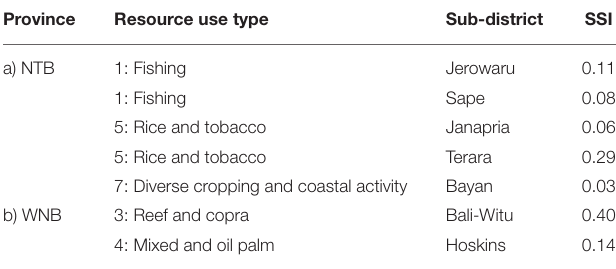
TABLE 2 | Steinhaus Similarity Index (SSI) of adaptation strategies for villages within the case study sub-districts in NTB and WNB.